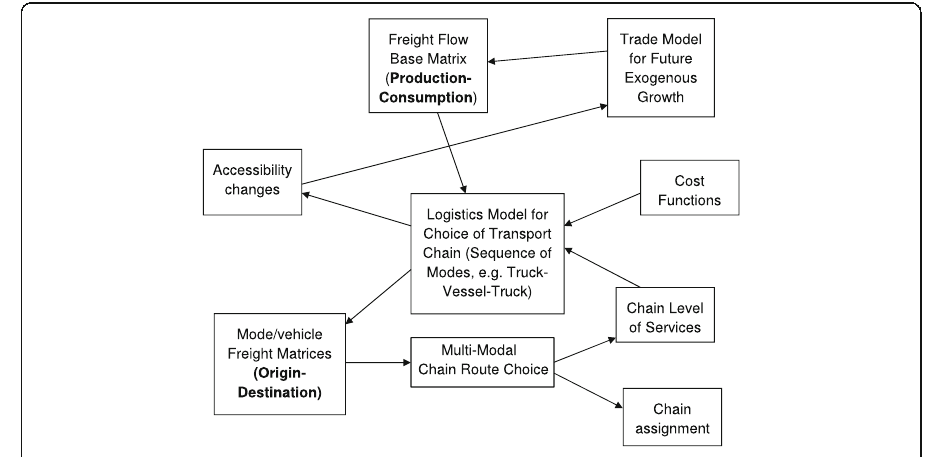
Fig. 1 General structure of the Transtools3 freight and logistics